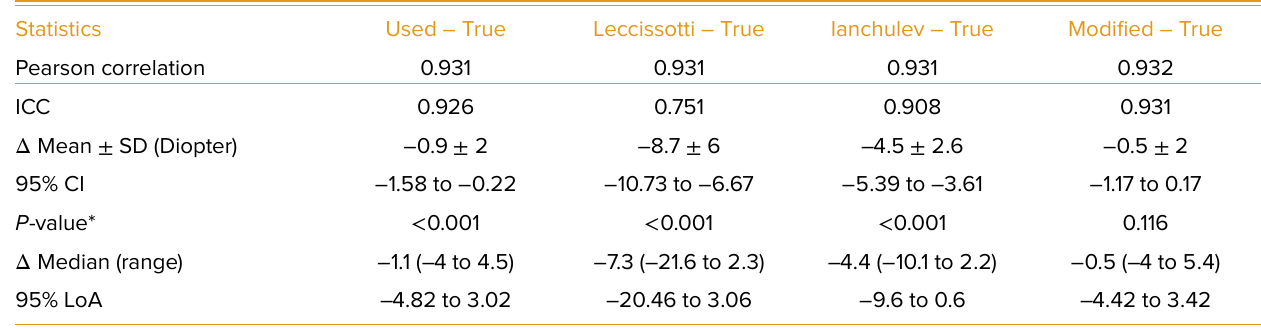
Table 3. Comparison between IOL power calculated with different formulas subtracted from the true